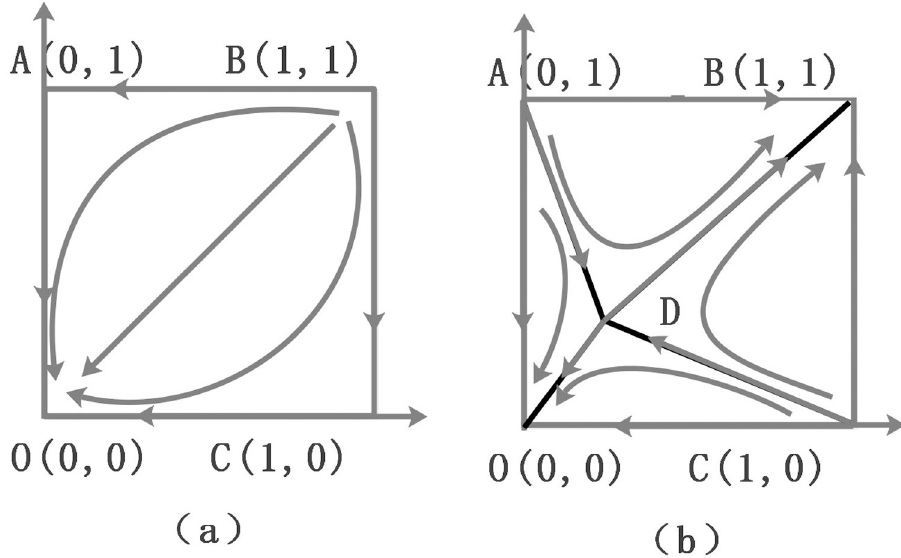
Fig 3. The phase diagram of evolutionary dynamic process.